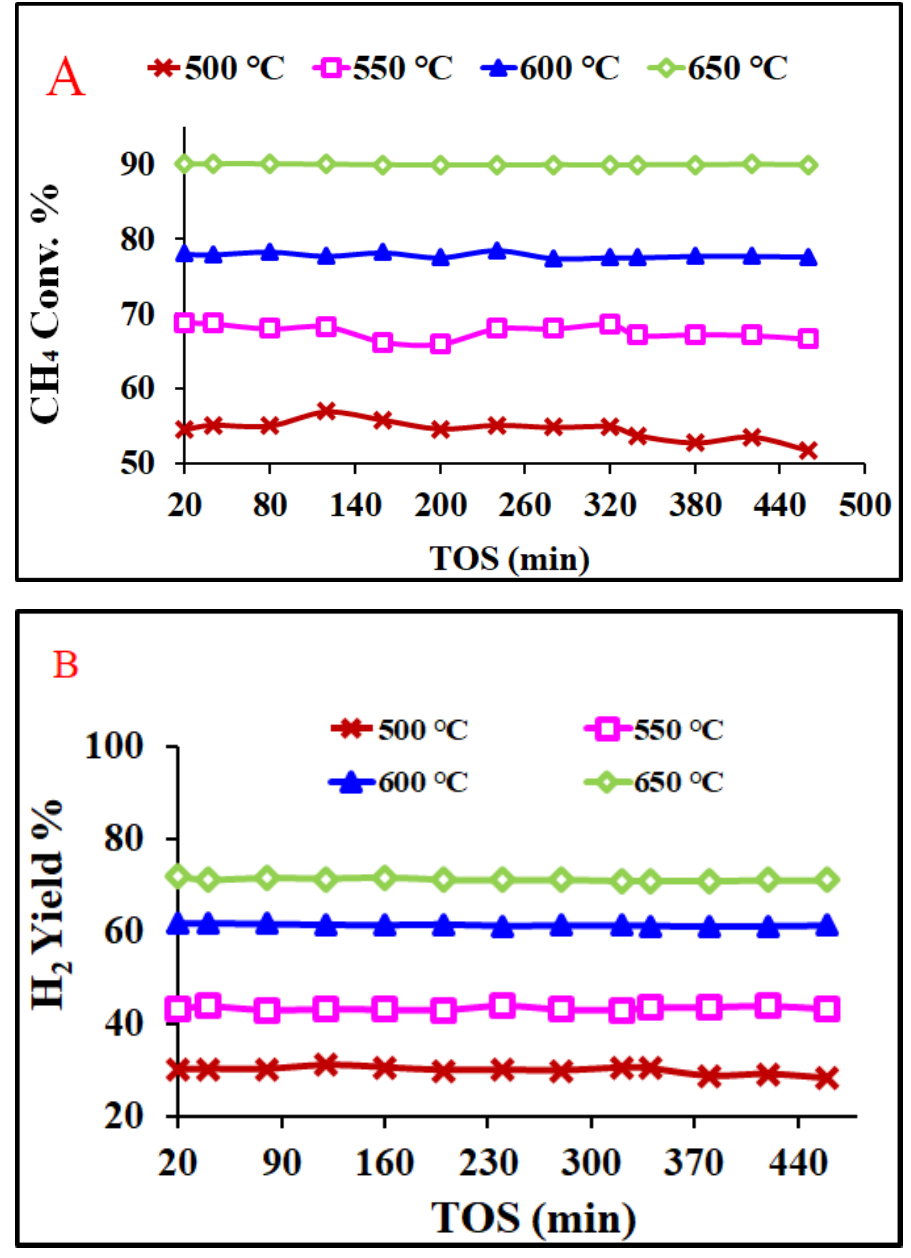
Figure 11. (A) Conversions of CH 4 and (B) H 2 yield during a 7 h stability test of the Ni-Al-H-600 Figure 11. ( A ) Conversions of CH 4 and ( B ) H 2 yield during a 7 h stability test of the Ni-Al-H-600 catalyst; activation 750 °C; reaction temperatures (500–650 °C), F/W = 19500 mL/g-cat. catalyst; activation 750 ◦ C; reaction temperatures (500–650 ◦ C), F / W = 19,500 mL /